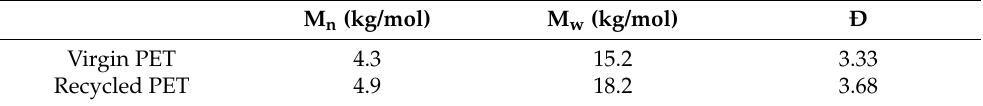
Figure 9. SEM analysis of ( A ) virgin and ( B ) recycled polyester fabric.